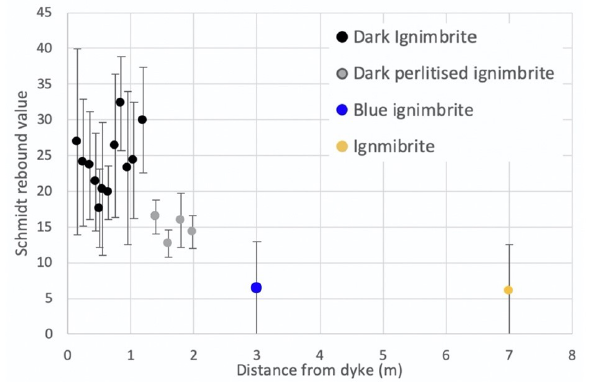
Figure 4: Schmidt hammer rebound values measured as a function of distance from the dyke margin. Sym- bol colours as in previous graph, and note many values were taken between 3 and 8 m from the dyke and all were below the detection limit of the Schmidt